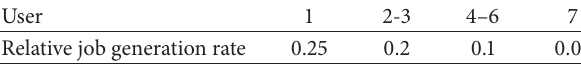
Table 2: Relative job generation rate of users.